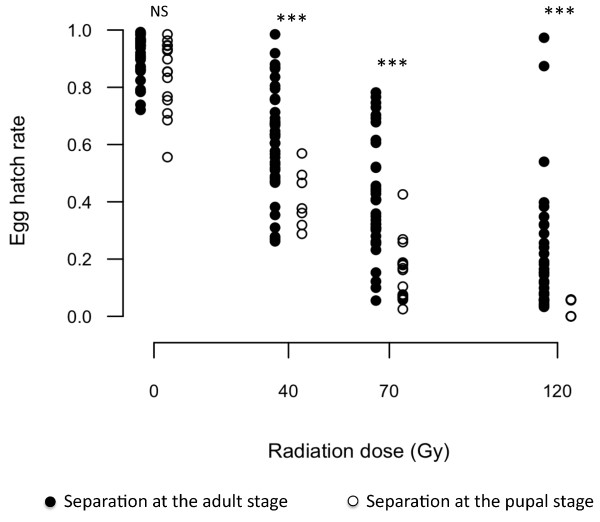
Distribution of the egg hatch rates after mating with irradiated males. Individual egg hatch rates for females separated as adults (black dots) or as pupae (circles) and mated with males irradiated at different doses. NS indicates no significant difference and *** indicates a significant difference (P < 0.001) between the two groups of females.